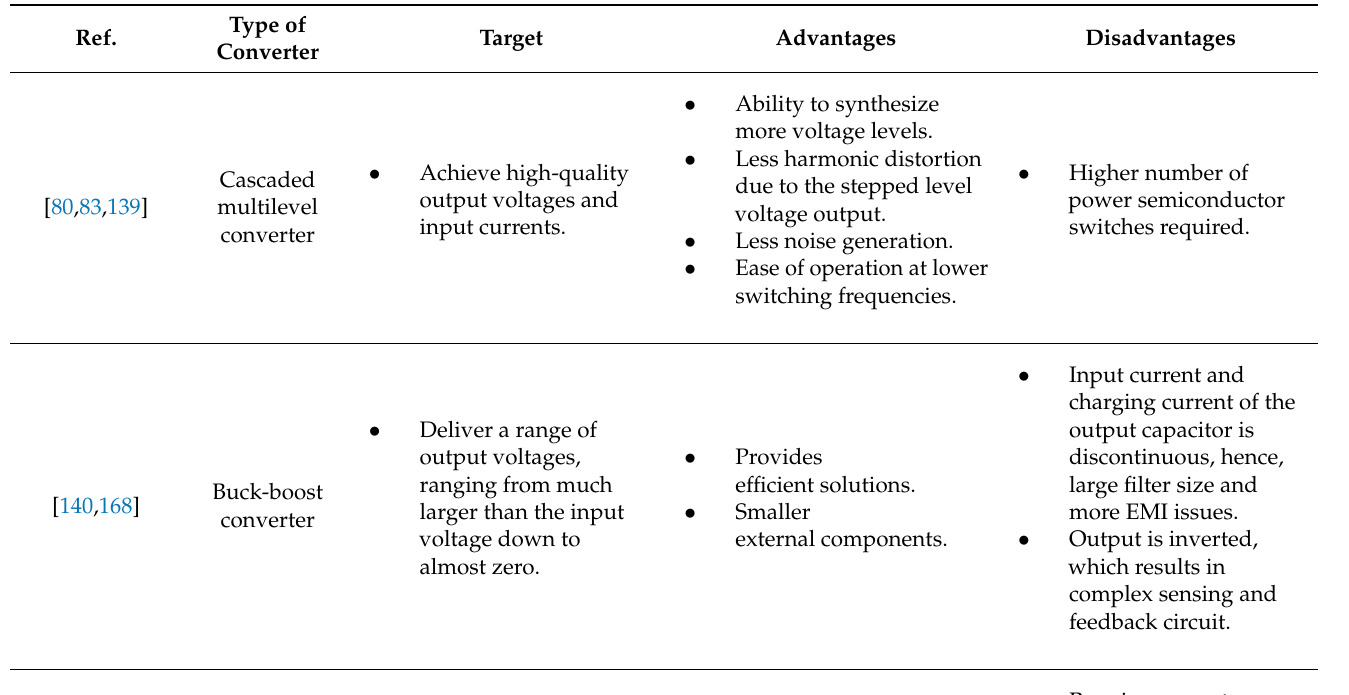
Table 5. Comparative study of different power electronics converters used in EVs.